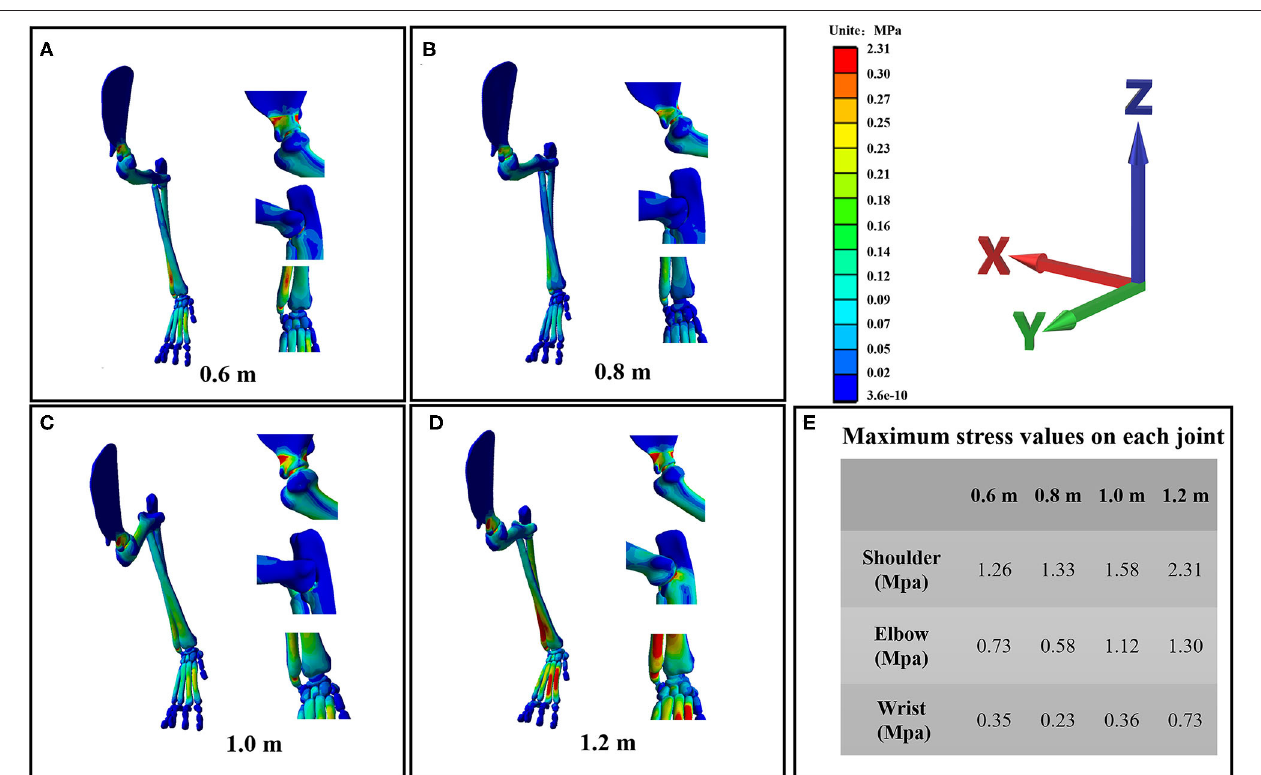
FIGURE 5 | (A–D) are the stress distribution details of the wrist joint, elbow joint, and shoulder joint of the cat’s right forelimb landing from four heights of 0.6, 0.8, 1, and 1.2m, respectively. (E) The maximum stress value of each joint at each landing height.